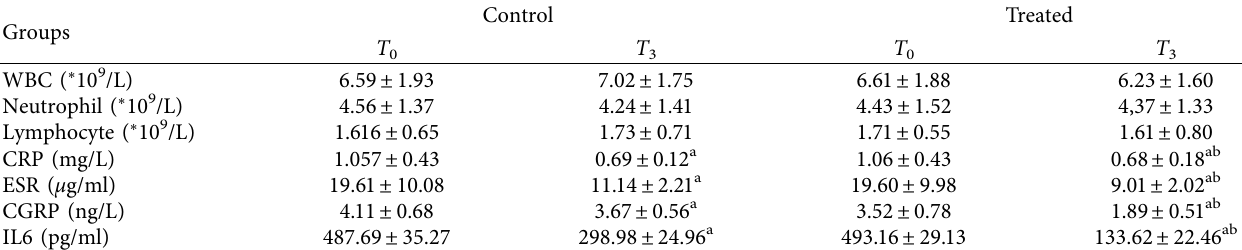
Table 5: Serum inflammatory indexes during hospitalization between two groups of patients.